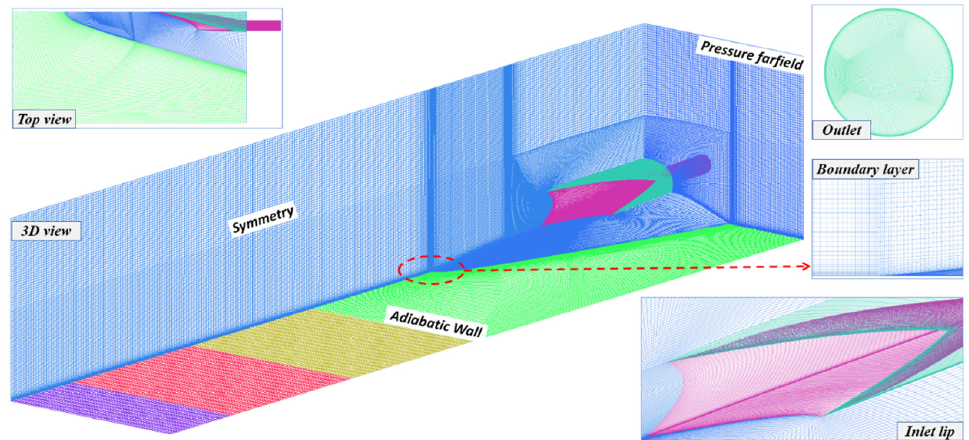
Table 1. Gird independence analysis ( M ∞ = 6.0, H = 24 km).